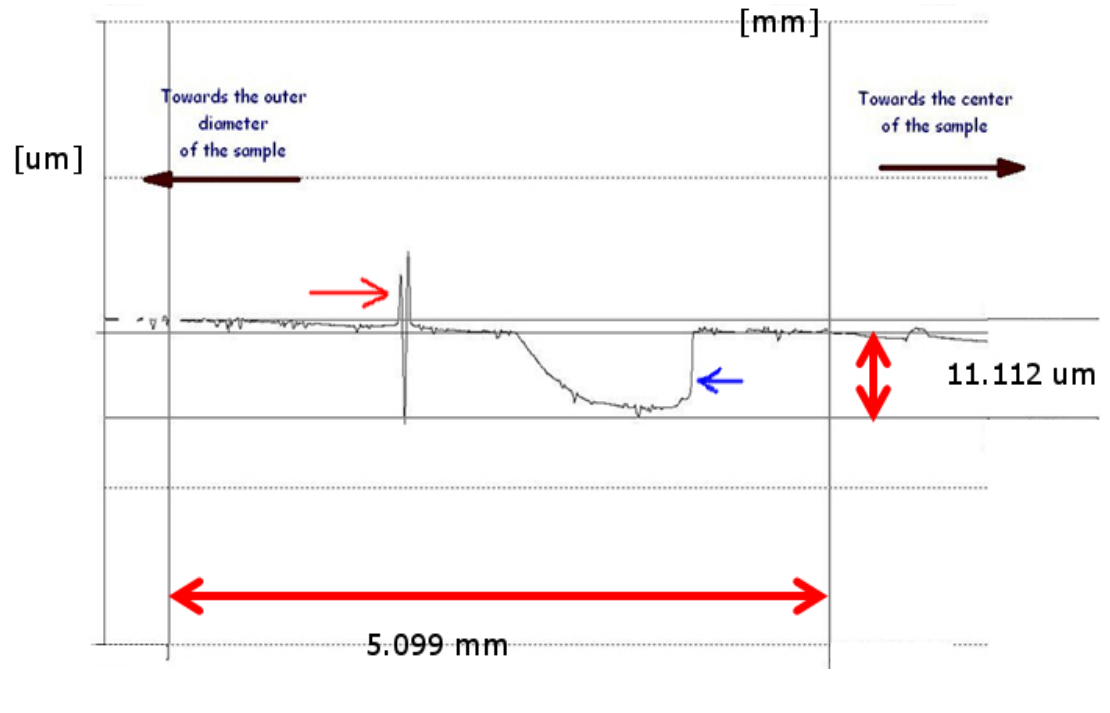
Figure 11. Recorded profile across the wear track on a LST sample after 1000 m of sliding